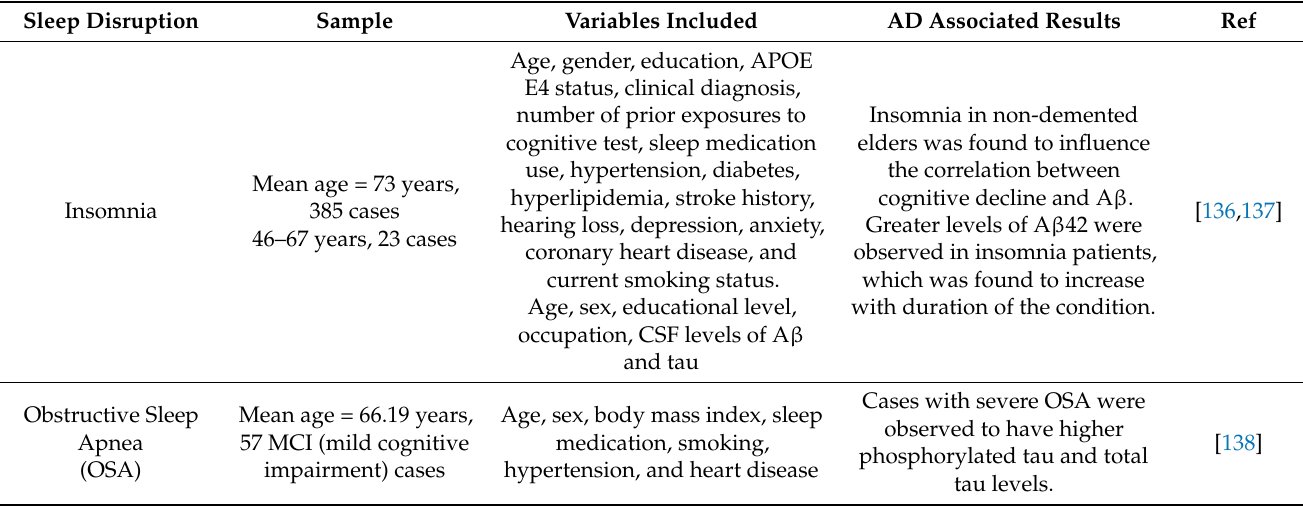
Table 6. Sleep disruptions and AD-associated